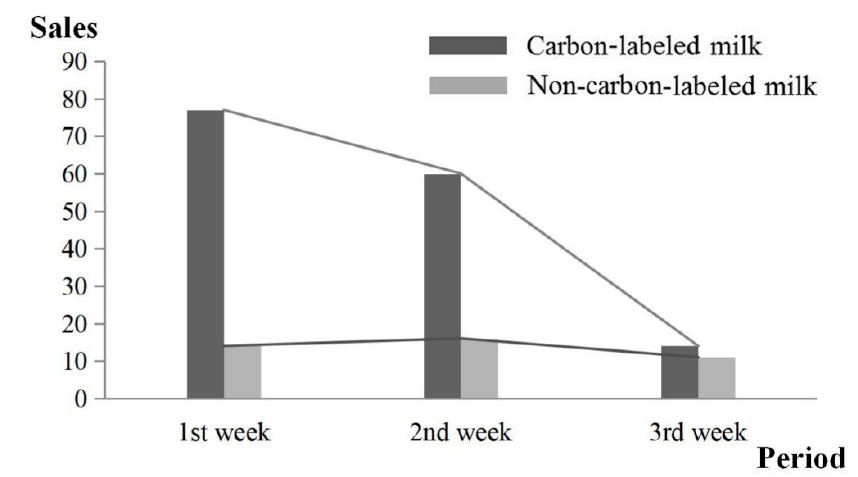
Figure 5. Sales volume of milk in the three periods.